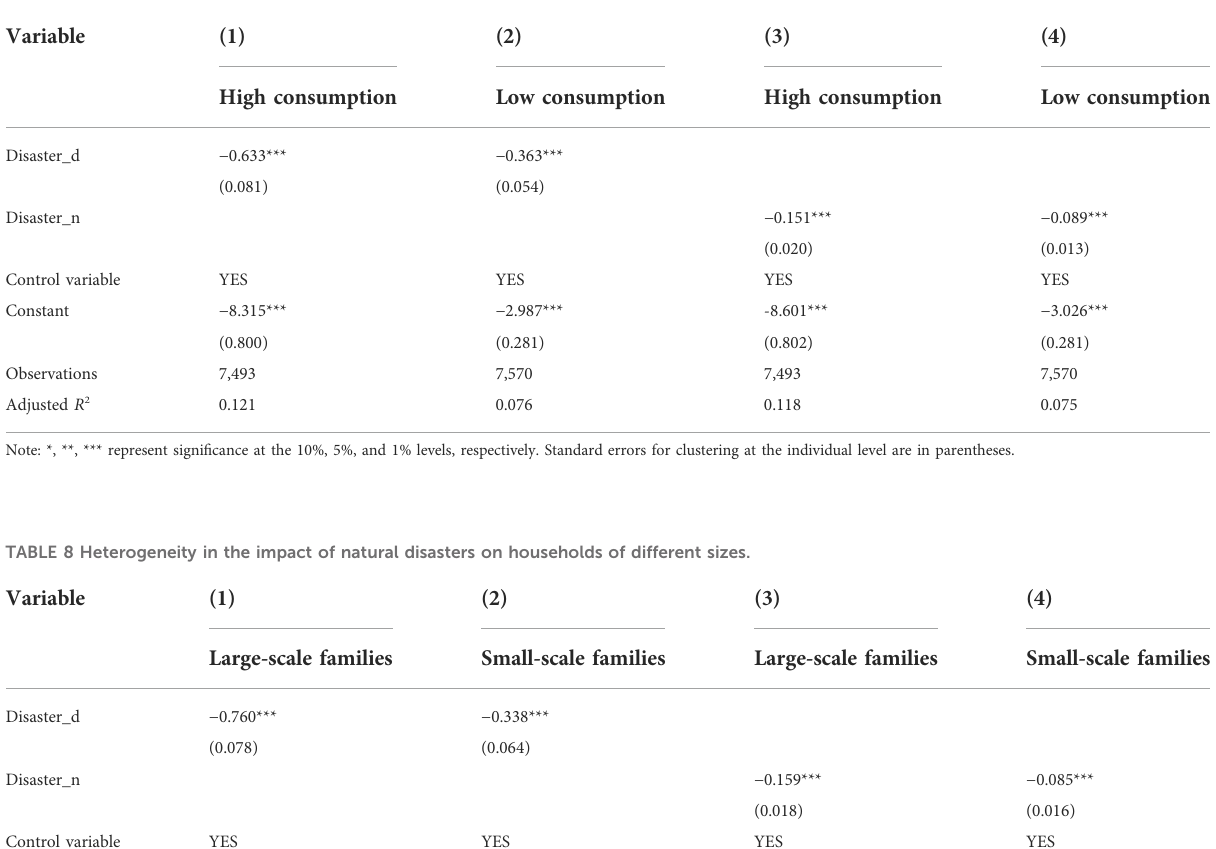
TABLE 7 Heterogeneity in the impact of natural disasters on households at different levels of consumption.